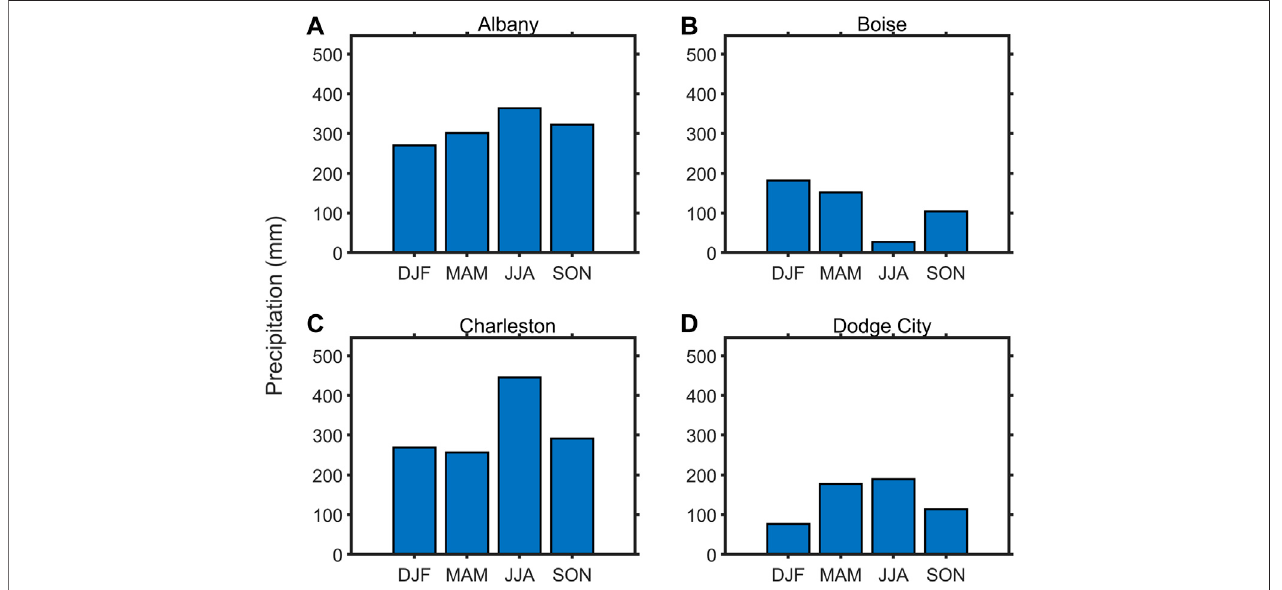
FIGURE 11 | Seasonal variation of the total precipitation over the four stations. (A – D) Albany, Boise, Charleston and Dodge City.